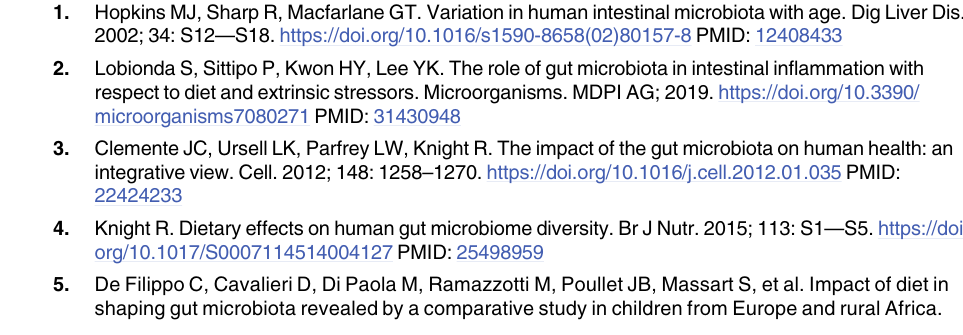
S1 Table. Nutritional content of pickled and fermented vegetables provided in the study. S2 Table. Median values for selected dietary variables before and after the six-week